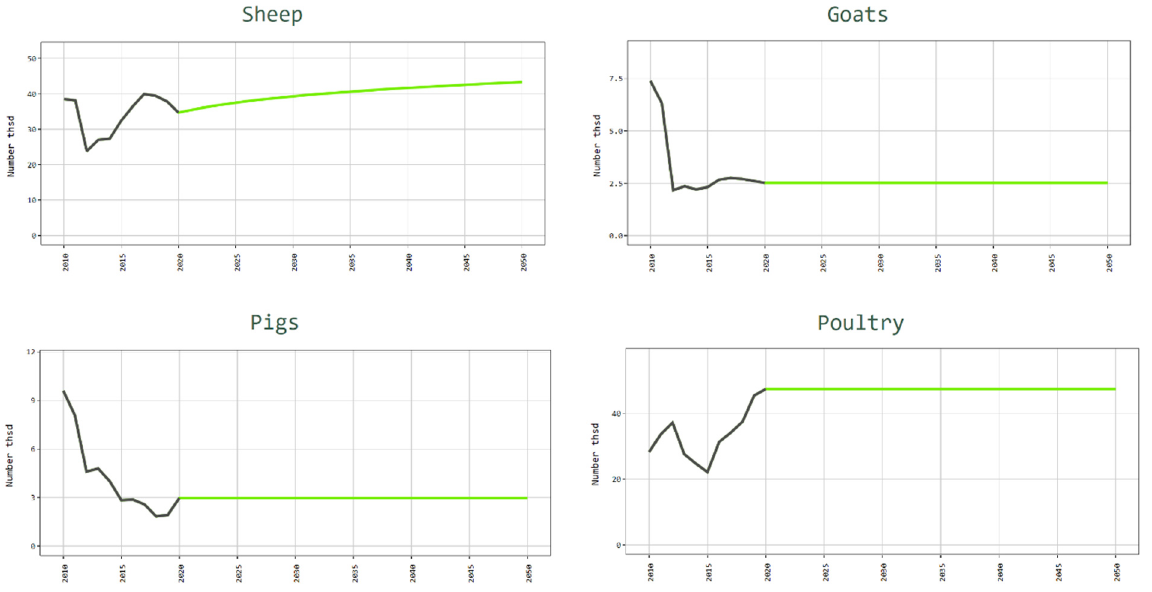
Figure 19. Number of animals in organic farming in Latvia in 2010–2020, with a projection for 2021–2050, thousands [62].